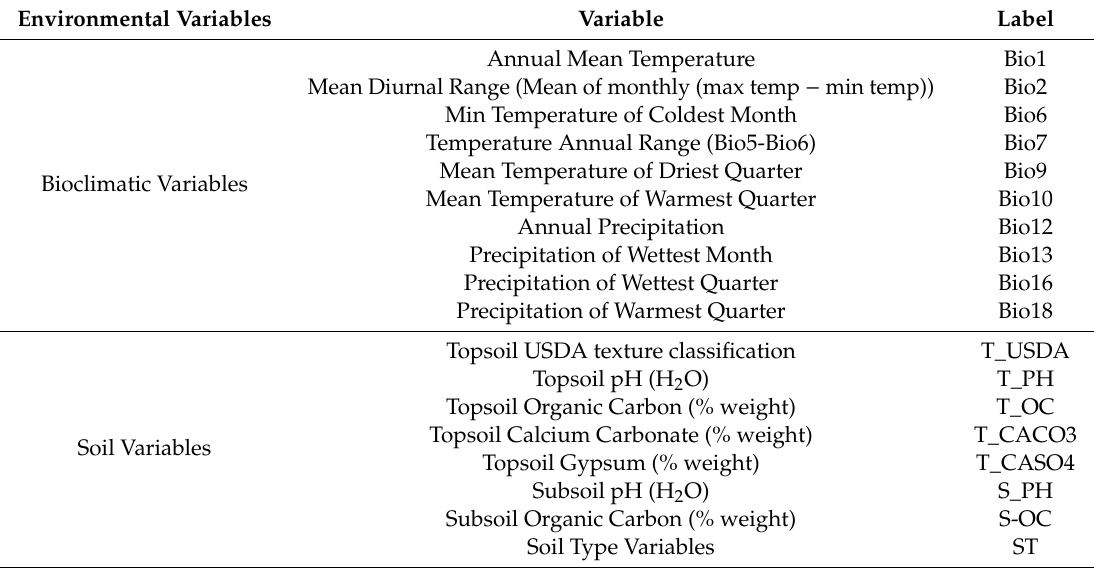
Table 1. Environmental variables used for predicting potential distribution of C. deserticola